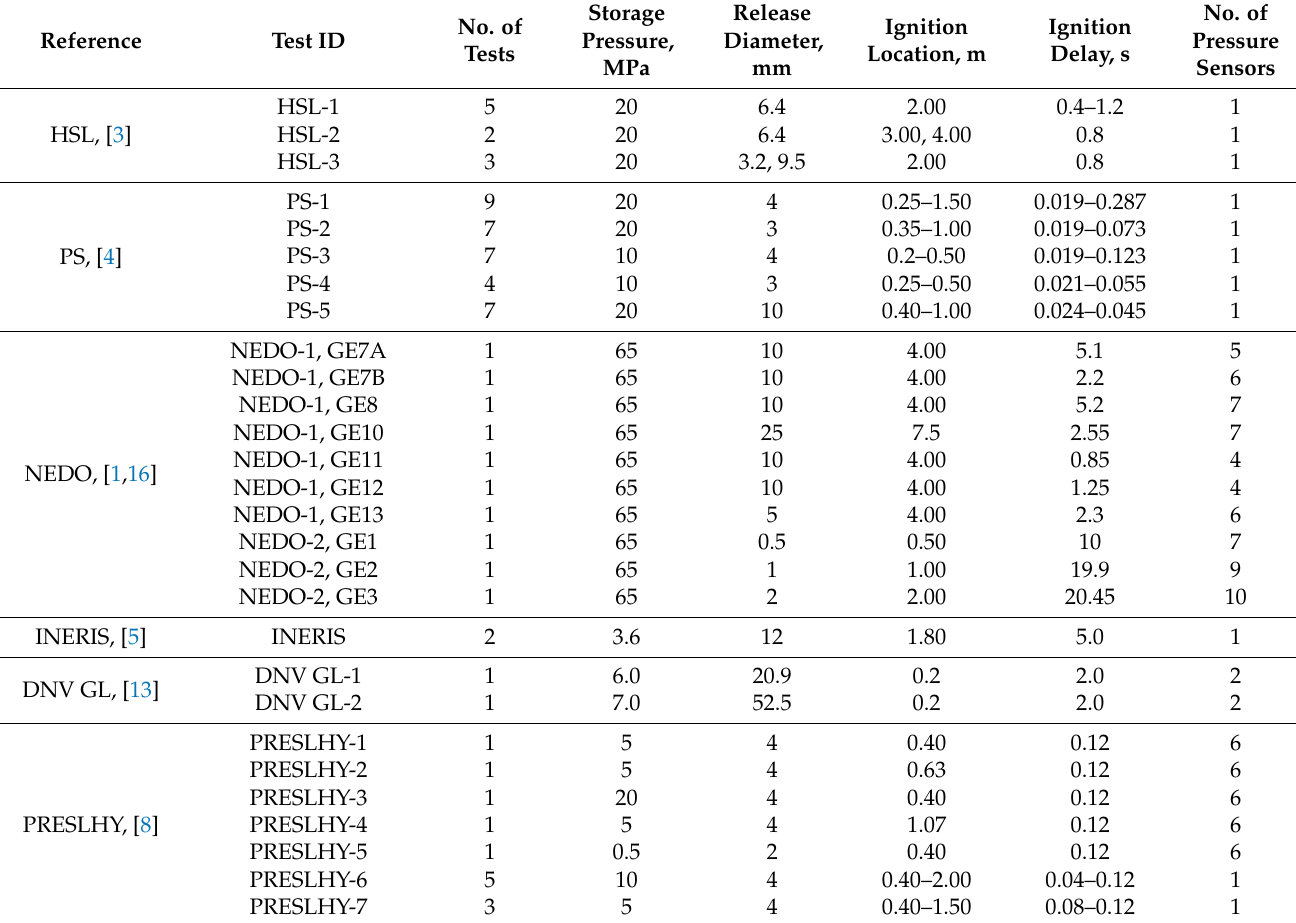
Table 1. Experimental conditions of the validation tests at ambient hydrogen storage